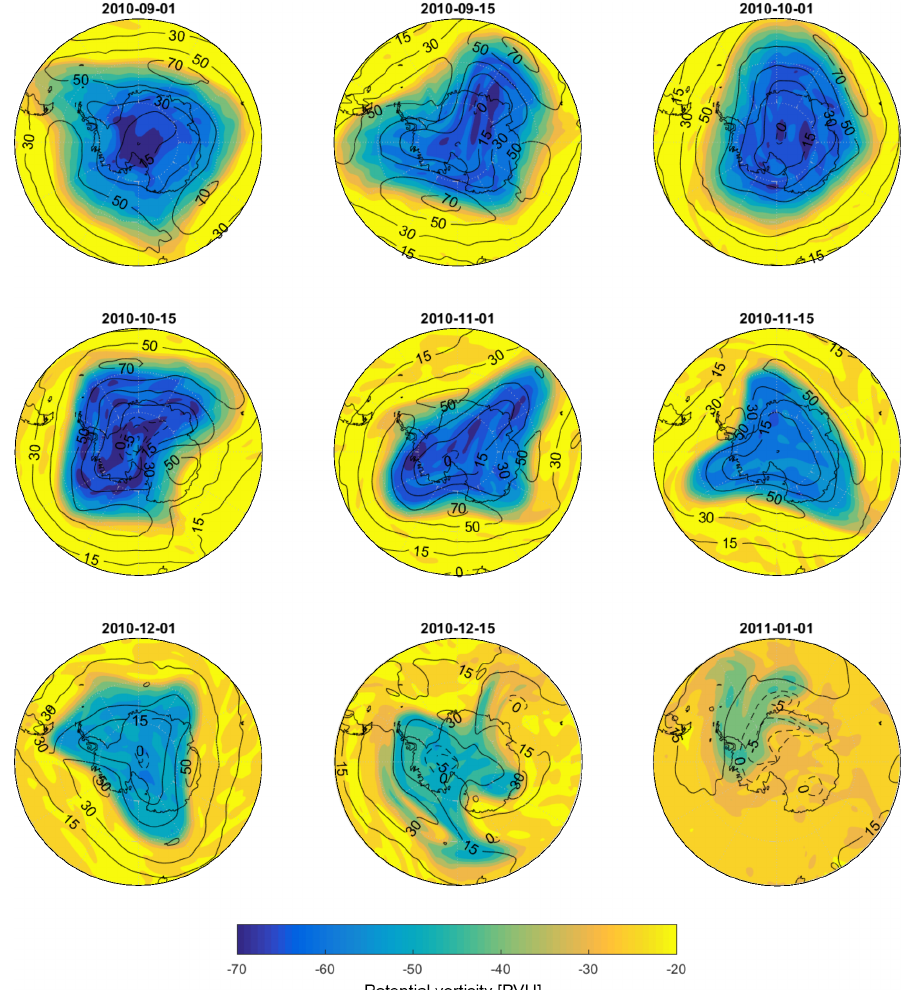
Figure 4. ERA-Interim potential vorticity (1PVU = 10 − 6 Km 2 s − 1 kg − 1 ; shaded) and zonal wind contours (ms − 1 ; black curves) on the 475K isentropic surface. Data are shown for 00:00UTC on selected days. Outer circles of the polar maps indicate a latitude of 45 ◦ S. The prime meridian is oriented towards the top of the